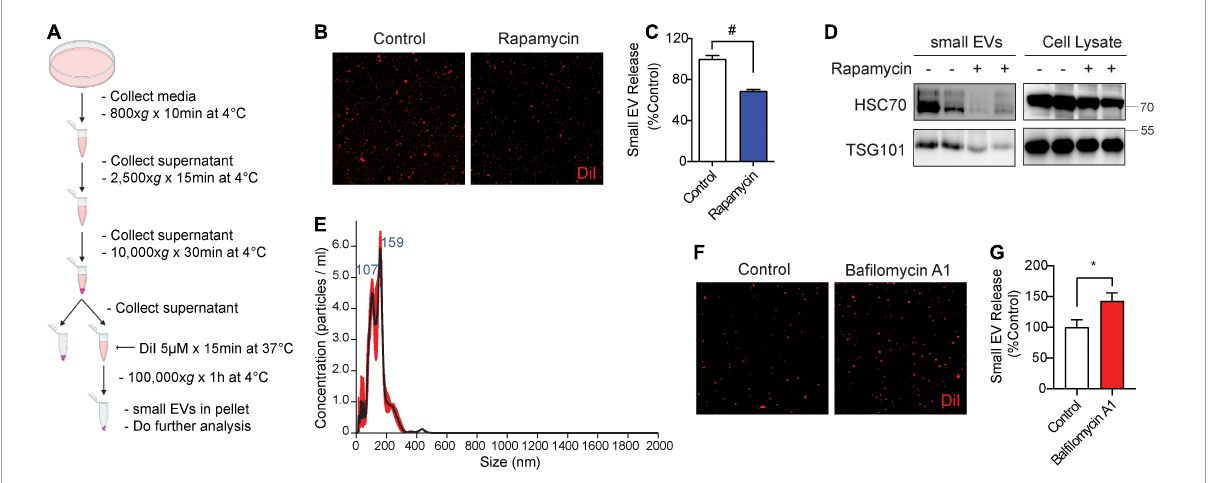
FIGURE1 Rapamycin decreases and bafilomycin A1 increases small EV secretion. (A) Schematic of small EV isolation method. (B) Representative images of DiI-stained small EVs secreted from NIH3T3 cells with or without 200 nM rapamycin treatment for 24 h. (C) Quantification of secreted small EVs for (B) . Data are presented as means ± SEM. n = 3 independent experiments, t -test, # P < 0.0001. (D) Representative immunoblots for the indicated proteins in secreted small EVs and cell lysates from NIH3T3 cells with or without 200 nM rapamycin treatment for 24 h. (E) Representative NTA analysis of small EVs isolated from NIH3T3 cells. The black line indicates concentration and size of particles, and the red line indicates standard error. (F) Representative images of DiI-stained small EVs secreted from NIH3T3 cells with or without 200 nM bafilomycin A1 treatment for 6 h. (G) Quantification of secreted small EVs for (F) . Data are presented as means ± SEM. n = 4 independent experiments, t -test, * P =